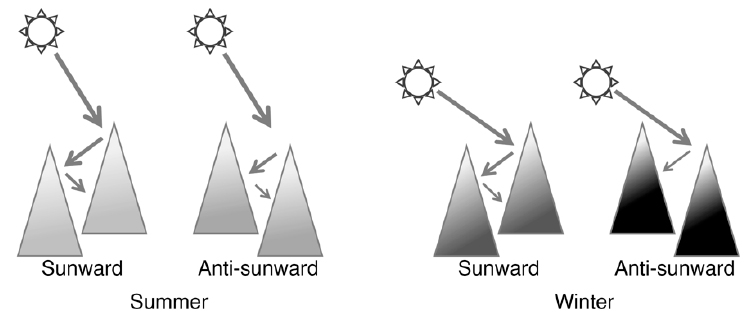
Figure 19. Effect of canopy reflection on the brightness of sunward and anti-sunward canopy. Figure 19. E ff ect of canopy reflection on the brightness of sunward and anti-sunward